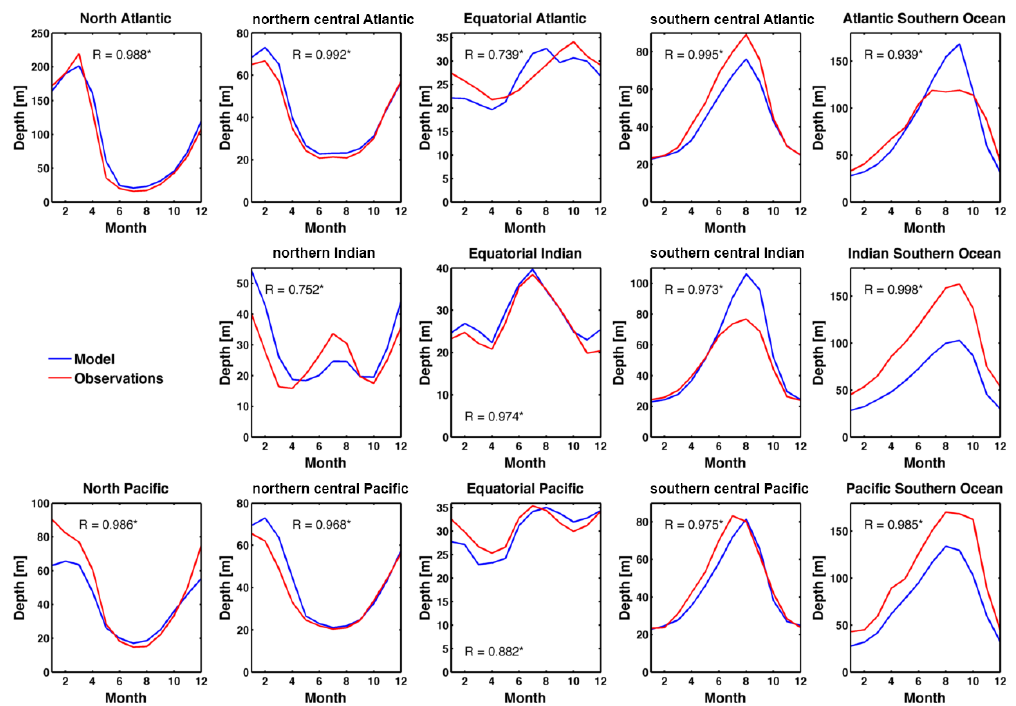
Figure 6. Mean MLD over the year in the ocean basins depicted in Fig. 3. The correlation coefficient is written in each plot, and the statistically significant correlations ( p values < 0 . 05) are marked with ∗ .